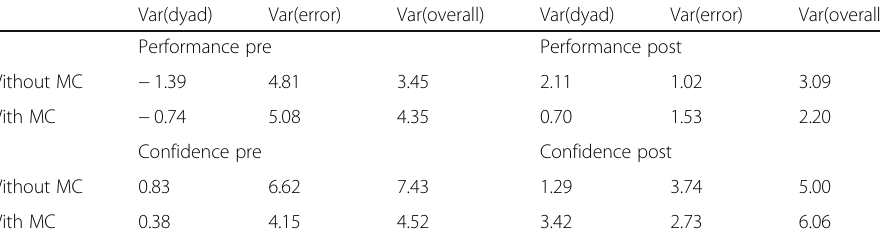
Table 4 Variance decomposition (ANOVA) for performance and confidence pre and post collaboration Var(dyad) Var(error) Var(overall) Var(dyad) Var(error) Var(overall) Performance pre Performance post Without MC 4.81 Confidence pre Confidence post